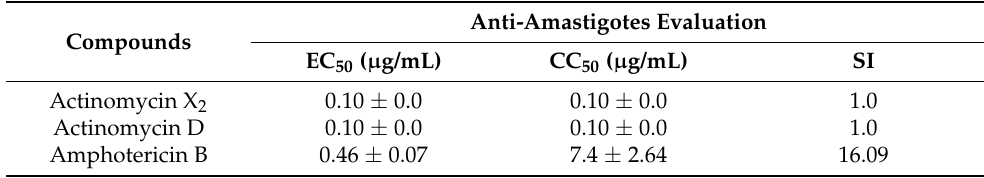
Table 2. Anti-amastigotes activity of tested compounds.